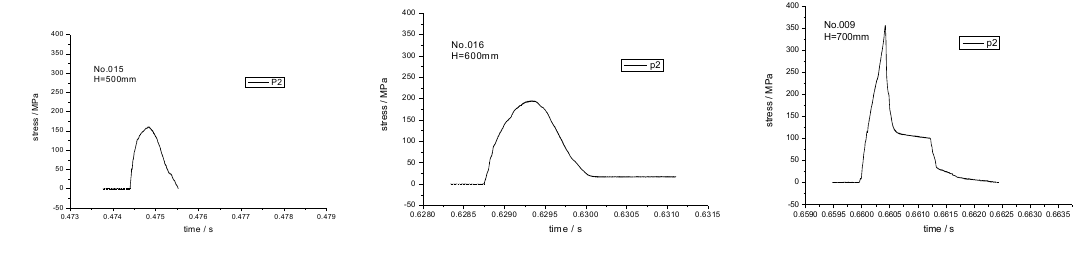
Figure 9. Pressure between PBX simulation material and support